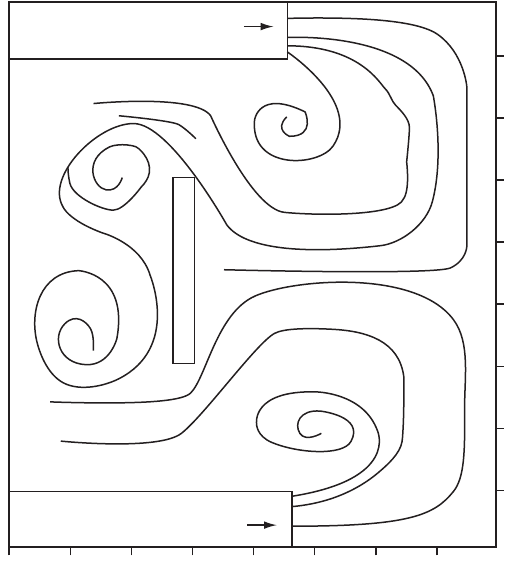
Figure 5. Halva and Volny model of quench tank flow uniformity (Adapted from reference 5